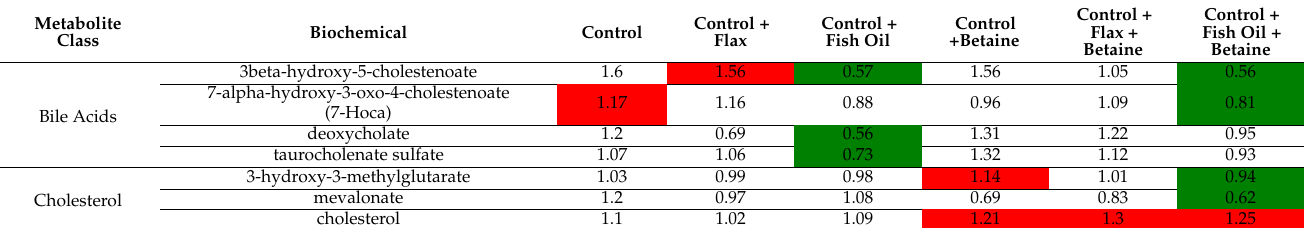
* This table consists of all analytes that had a p ≤ 0.05 and a q ≤ 0.1 for both change during the study and a difference between treatments at the end of the study. Values are change during the study while eating the listed food. Green denotes a decline and red an increase in the ratio (Final concentration/Initial concentration) of that compound. Table 12. Bile acids and cholesterol metabolites which changed during the study while consuming control, or betaine, flax, and fish oil supplemented foods